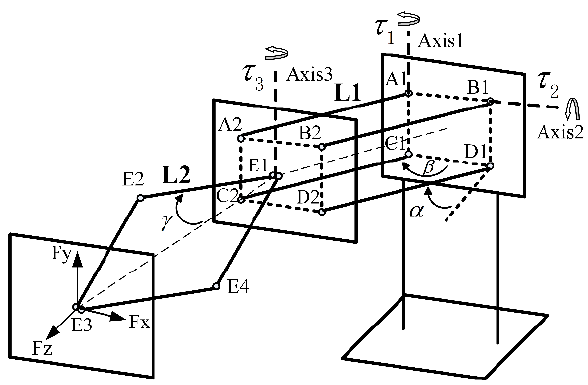
Figure 8. Model of translational force feedback.